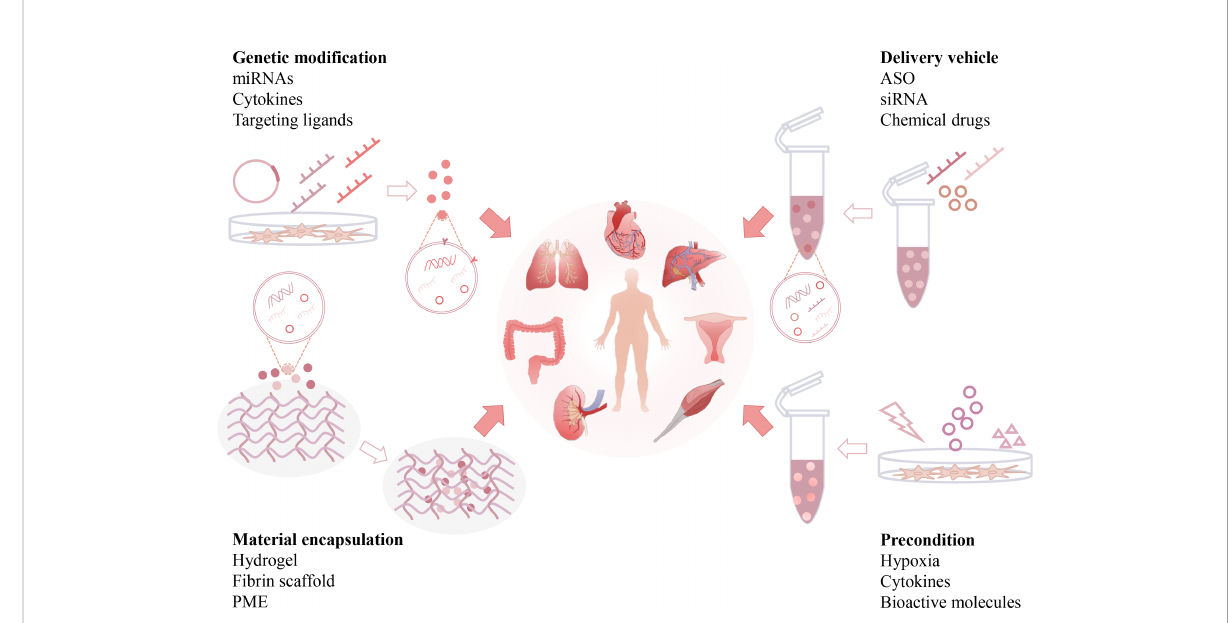
FIGURE 5 Engineering strategies of EV-based anti- fi brotic therapies. Native EVs can be re-engineered by multiple strategies, such as genetic modi fi cations, preconditions, loading with therapeutic reagents, and incorporation with functional materials. Engineered EVs can exhibit additional bene fi cial effects, such as enhanced drug payload, longer half-life, better organ targeting capability and bioavailability, and serve as advanced nanomedicines for the resolution of organ fi brosis. (Antisense oligonucleotide: ASO, pneumatic microextrusion: